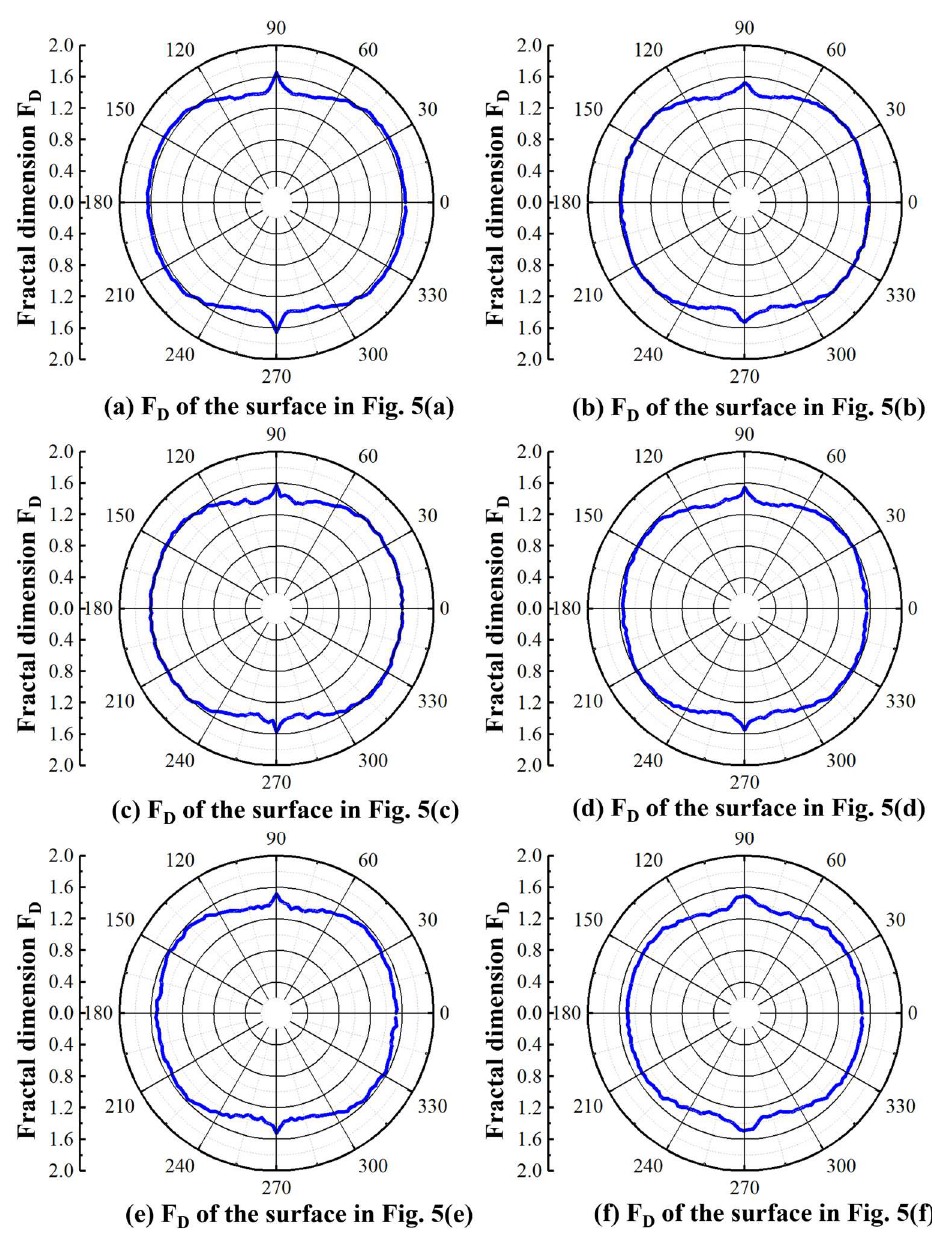
Figure 8. The circumferential 2D fractal dimension of micro-milled KDP surfaces processed with different milling